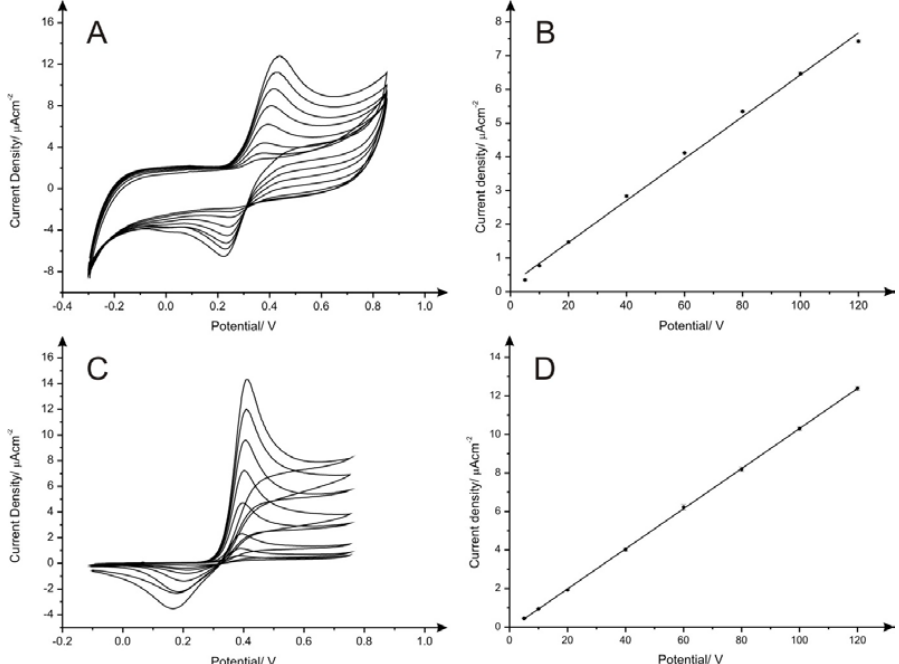
Figure 4. Cyclic voltammograms and calibration curves of acetaminophen using PDE1 drawn 60 times with HB pencil from Box 1 ( A ) and ( B ) and screen-printed electrodes ( C ) and ( D ) in 0.1 M pH 7.4 PBS/0.1 M KCl Each data point shown in ( B ) and ( D ) is the average and standard deviation of the replicates ( N = 3). Scan rate: 5 mV · s − 1 .